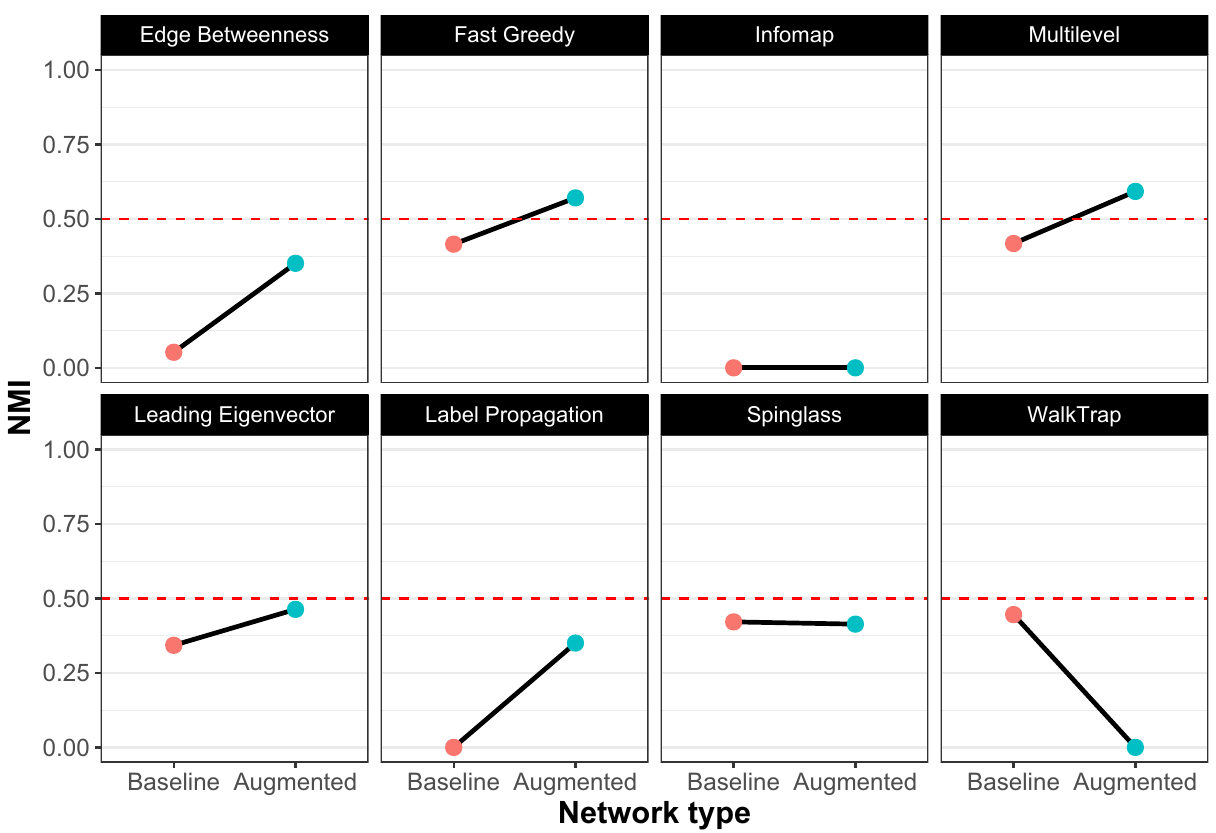
Figure 5. The performances of the 8 community detection algorithms are shown on the “baseline” (pink) and “augmented” (cyan) empirical network. The y-axis tracks the Normalized Mutual Information (NMI) value for each algorithm. As with the synthetic networks, Fast Greedy, Multilevel, and Spin-Glass outperform the others on the “baseline” network. The performances of FG and ML are yet again further enhanced with the augmented network, while that of WT is lowered. Overall, it is FG and ML on the augmented network, that perform the